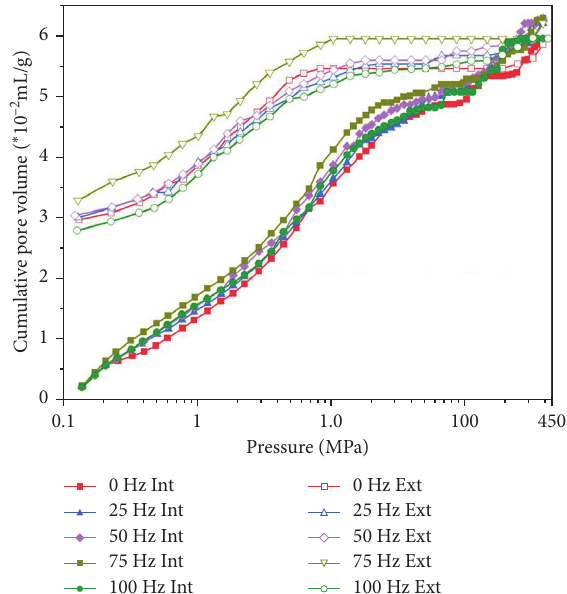
Figure 3: MIP intrusion and extrusion curves of the VDF coal